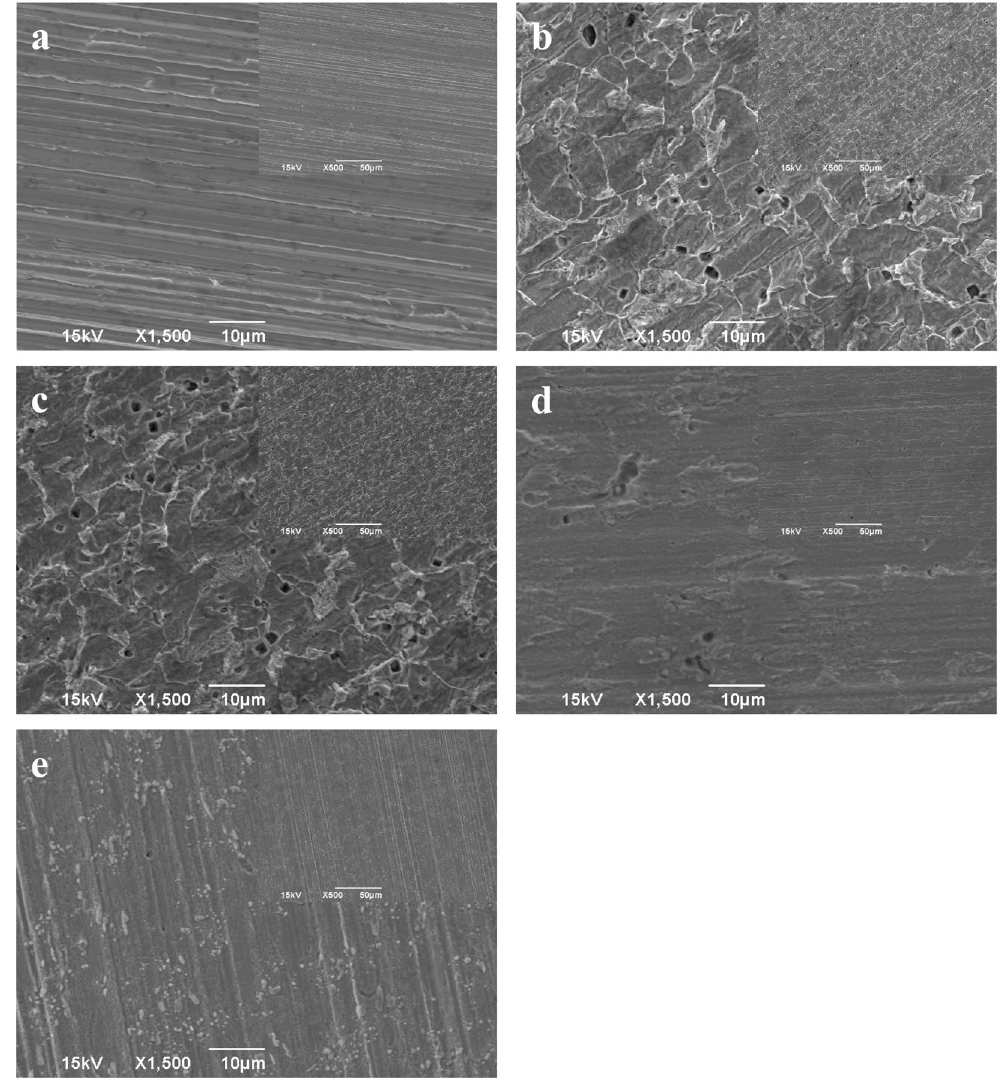
inserted images are 50 μ